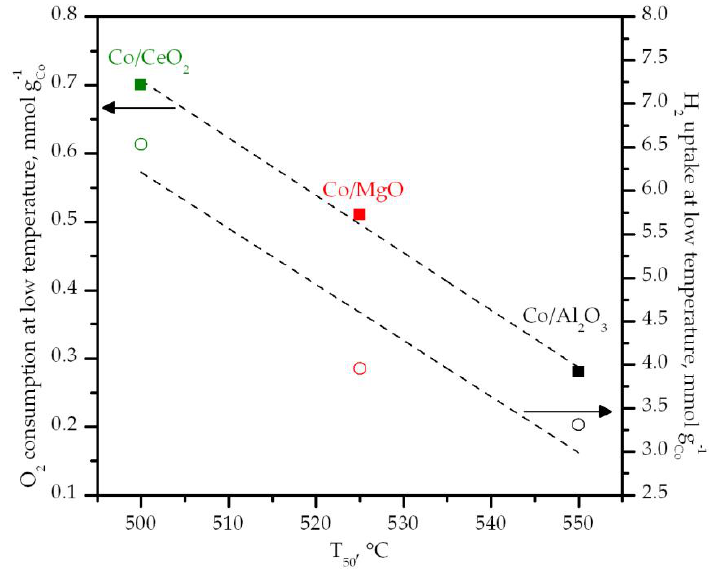
Figure 8. Relationship between the activity and the redox properties of the supported catalysts.